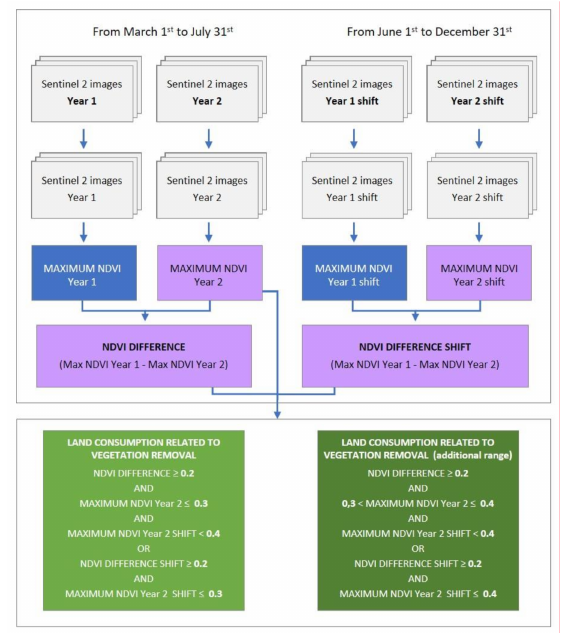
Figure 5. Workflow of the methodology of land consumption related to vegetation removal with the shift